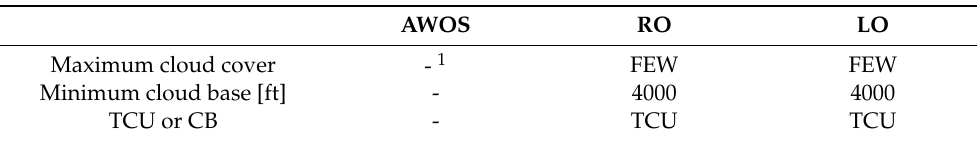
Table 5. The same as Table 4, but for 14 September 2018, at 09:50 UTC. TCU—towering cumulus and CB—cumulonimbus. AWOS RO LO Maximum cloud cover -